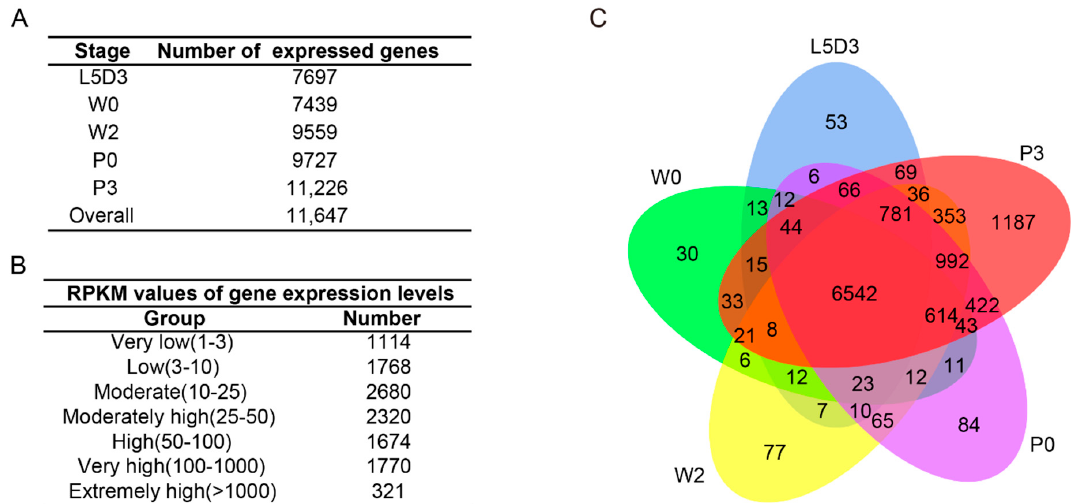
Figure 2. Transcriptome sequencing and gene expression profiling of the fat body at different stages during silkworm metamorphosis. ( A ) Number of genes expressed in the silkworm fat body at different developmental stages. ( B ) RPKM (reads per kilobase per million mapped reads) values of gene expression levels. ( C ) Venn plot analysis of the genes expressed in the silkworm fat body at each developmental stage. Blue, L5D3; Green, W0; Yellow, W2; Violet, P0; Red, P3; L5D3, the third day of the last larval instar; W0, just wandering; W2, the second day during wandering; P0, just pupation; and P3, the third day after pupation.